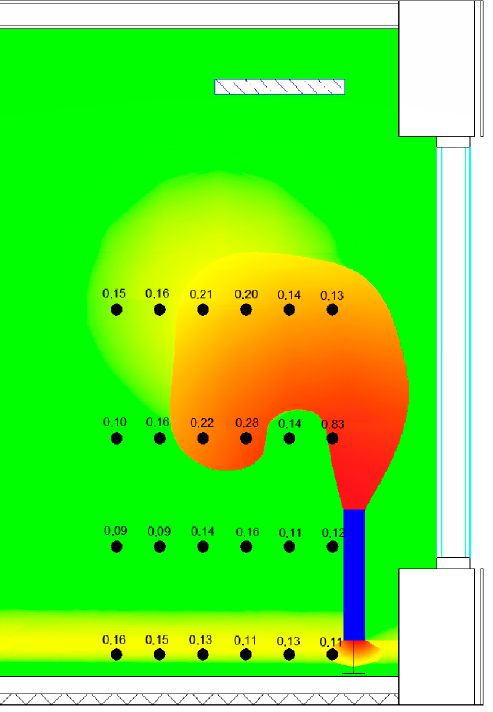
Figure 19. Air jet velocities for cooling radiators, LOW speed.